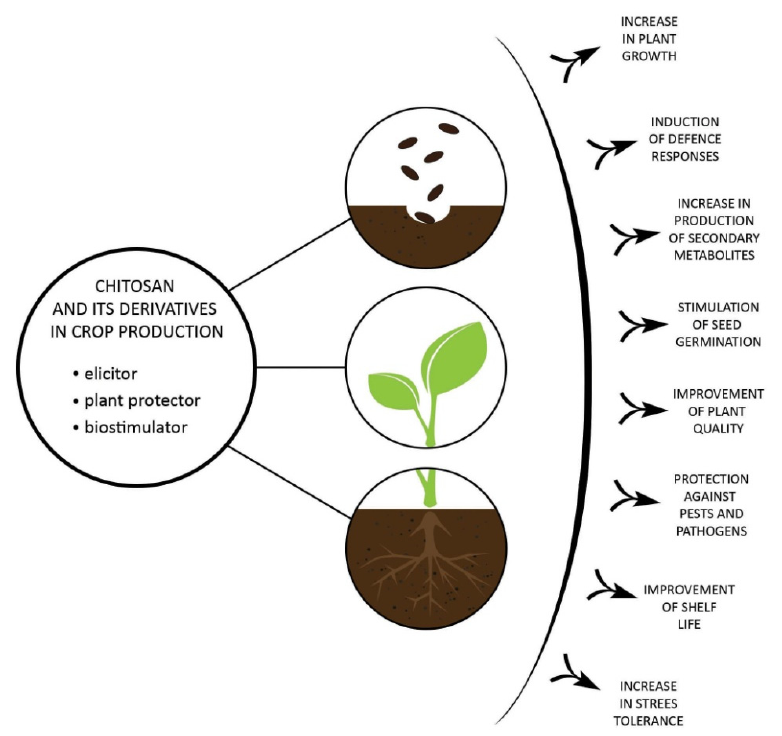
Figure 2. Application of chitosan and its derivatives in plant production.